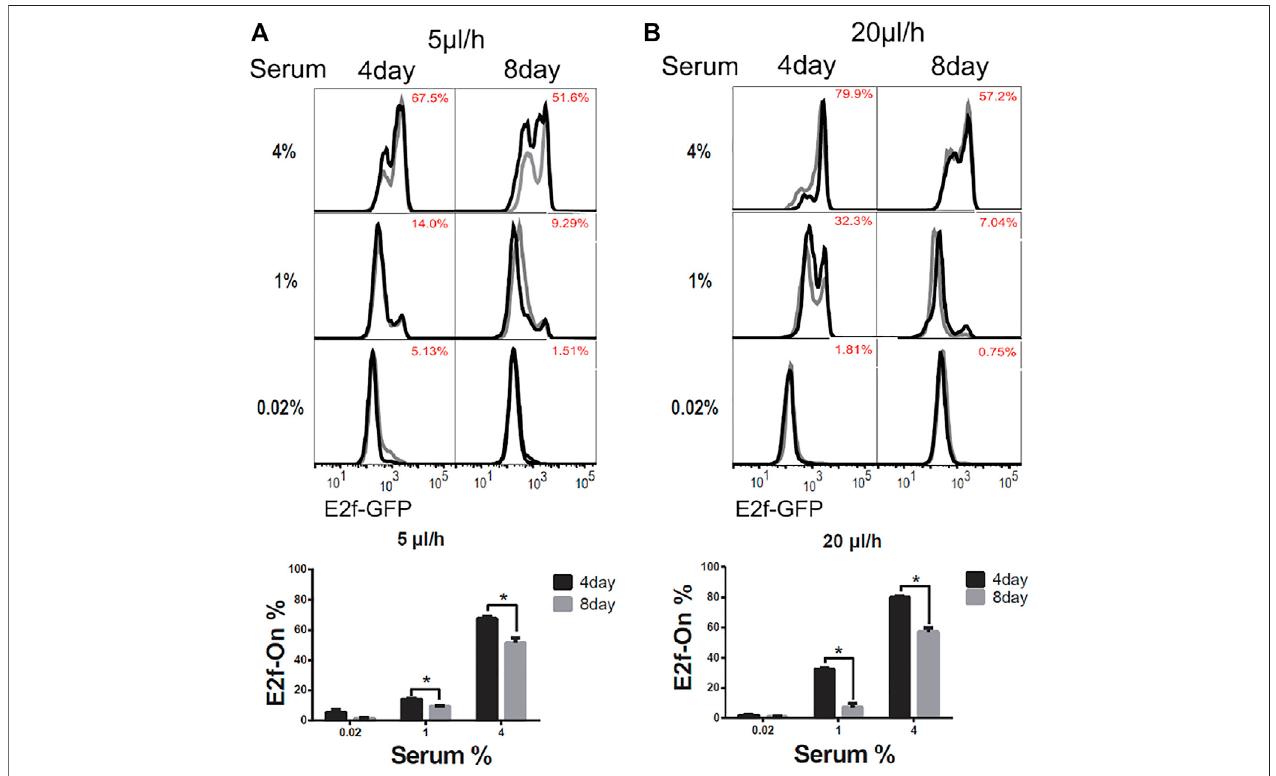
FIGURE 2 | Longer-term serum starvation under extracellular fl uid fl ow leads to deeper quiescence. REF/E23 cells seeded in micro fl uidic devices were induced to and maintained in quiescence by culturing them in serum-starvation medium for either 4 or 8 days under the medium fl ow rates of 5 μ l/h (A) and 20 μ l/h (B) . Cells were subsequentlystimulatedwithserumattheindicatedconcentrationsfor26 h,andtheE2f-On%wereassayed.(Top)E2f-GFPhistogramswithrednumbersindicatingthe average E2f-On% (the areas below the right “ peaks ” of the bimodal histograms; same below) from duplicate samples (black and grey). (Bottom) Statistic bar chart of the E2f-On% in cell populations (from the top) as a function of serum-starvation duration and serum concentration in serum-stimulation. Error bars, SEM ( n = 2), * p < 0.05.